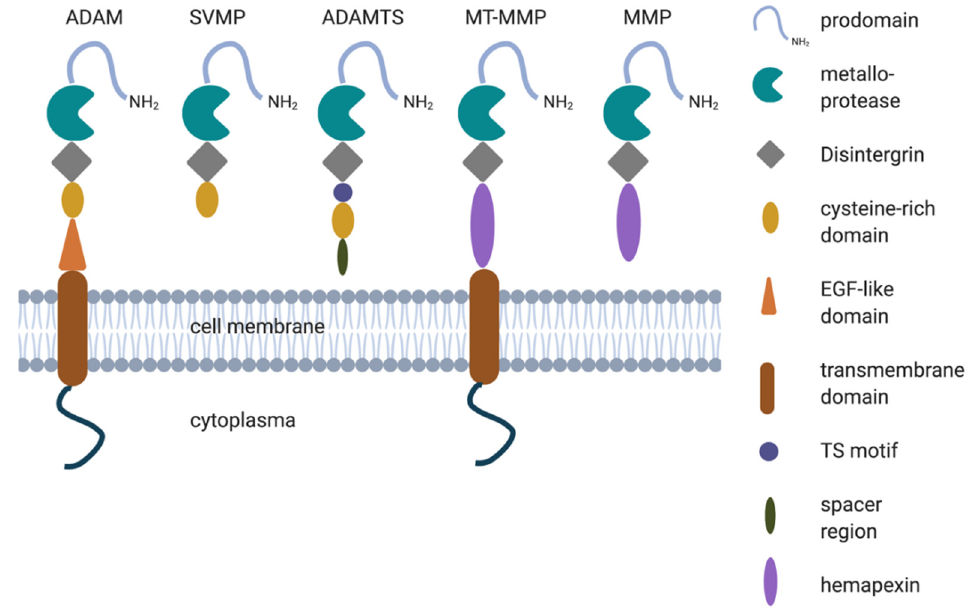
Figure 1. Protein structure of the members of the metzincin family of metalloproteases: A Disintegrin And Metalloprotease (ADAM), Snake Venom Metalloprotease (SVMP), A Disintegrin And Metalloprotease Thrombospondin motif (ADAMTS), membrane-type matrix metalloproteinases (MT-MMP) and MMP.